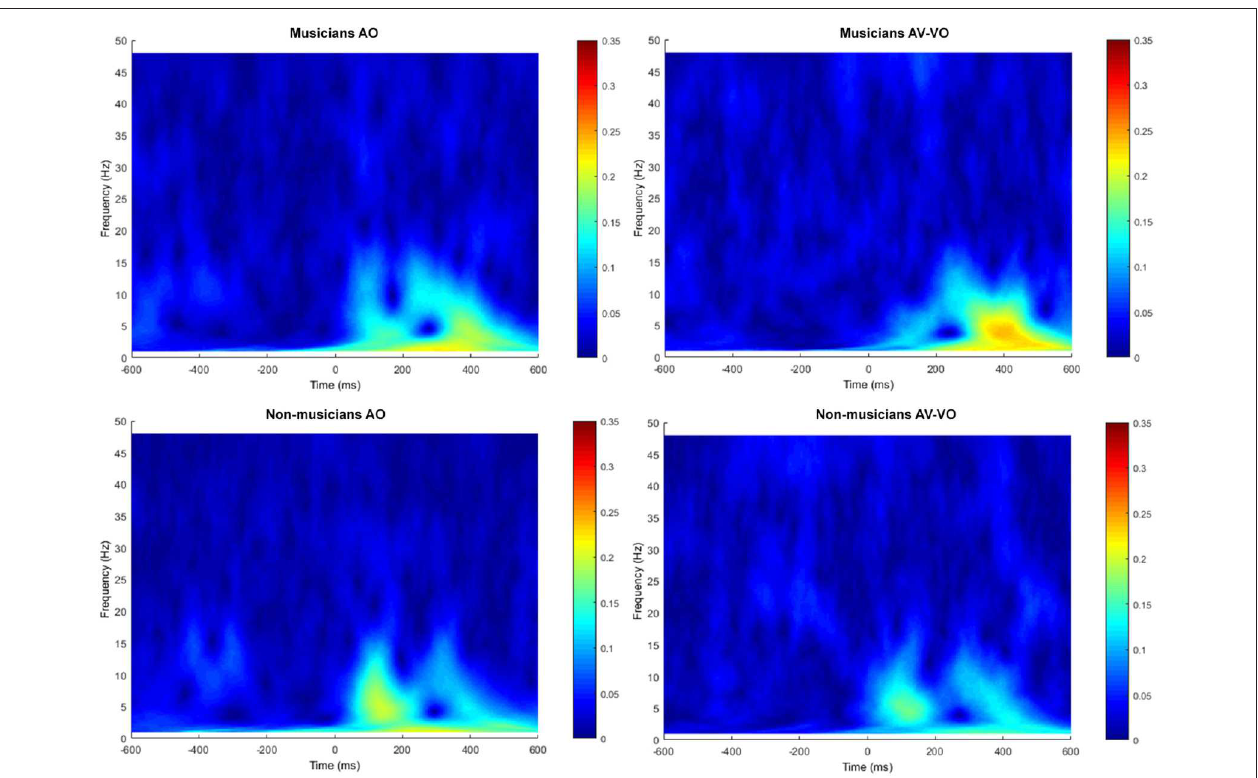
FIGURE 5 | Trial-to-trial phased-locking measured by ITPC for audio only (AO) and audiovisual minus video only (AV −